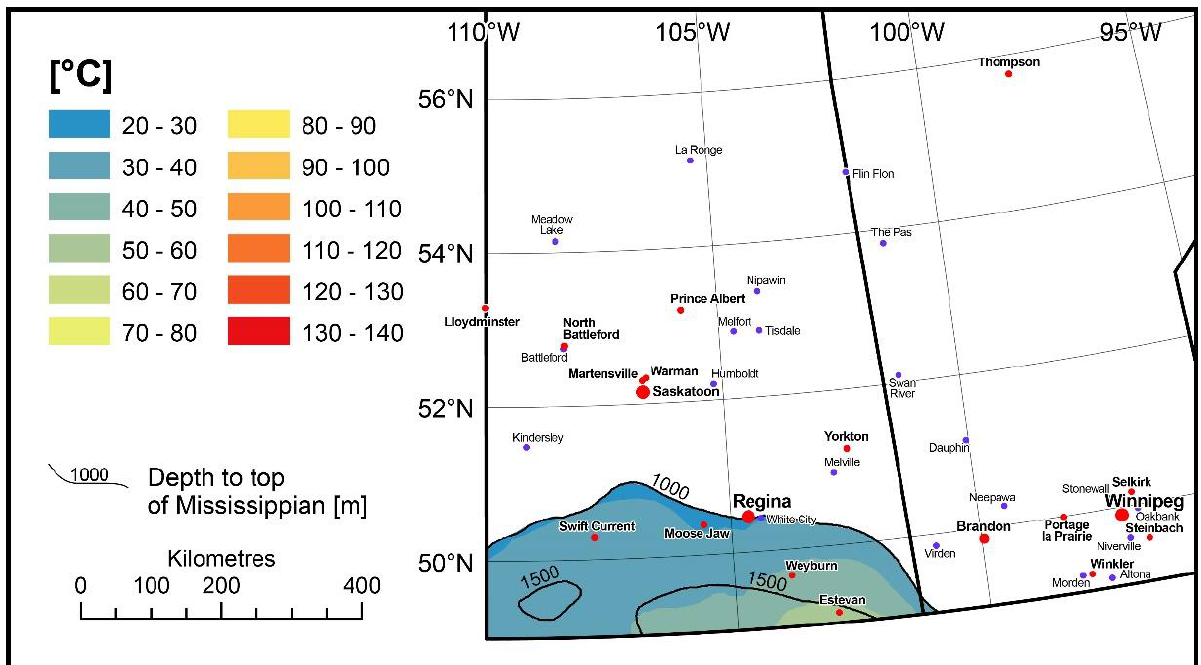
Figure A4. Temperatures top of Winterburn Group—Saskatchewan – Manitoba WCSB.